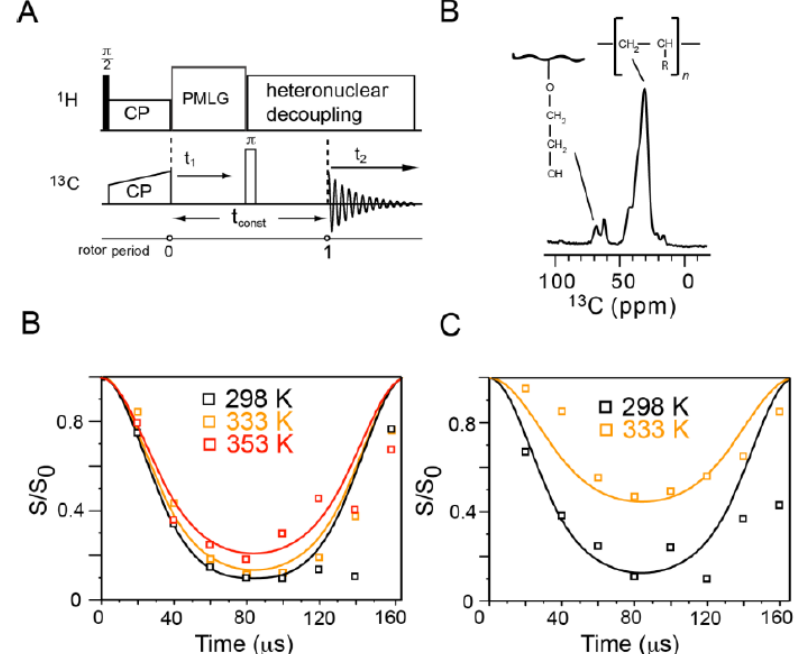
Figure 5. Measurement of motion-averaged 13 C- 1 H dipolar couplings of NPBA. ( A ) The NMR pulse sequence of the DIPSHIFT experiment; ( B ) Representative 1D projection of the DIPSHIFT spectrum, showing the resonances of backbone and side-chain CH data measured at 298 K, 333 K and 353 K; ( C ) The curve fitting of backbone CH 2 ( D ) Fitted side-chain CH data measured at 298 K and 333 K. Time on x-axis refers to the 2 evolution time in t1 period.